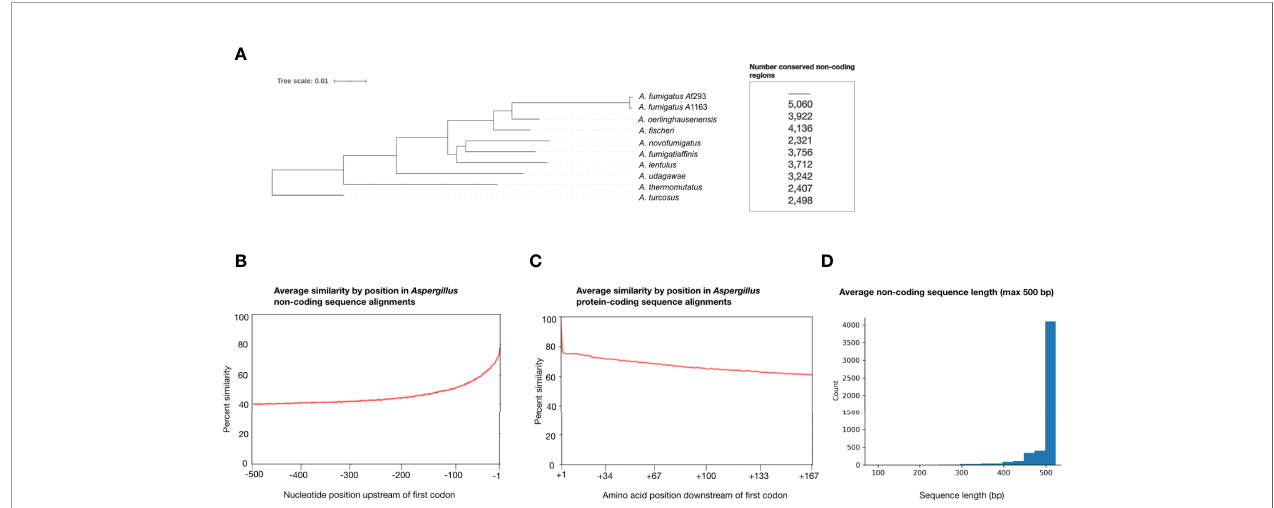
concatenation analysis of a 5,215-gene data matrix. Branch lengths correspond to nucleotide substitutions/site. Note the long branch leading to A fumigatus , indicative of a greater number of nucleotide substitutions per site in this species. The number of genes whose non-coding regions were conserved ( ≥ 75% sequence similarity between each species and ≥ 500 bp in length) between A. fumigatus Af293 and each species are shown next to the corresponding taxa. (B) Average percent sequence similarity of non-coding regions of 5,215 genes byposition,relativeto the gene ’ s fi rst codon. Sequence alignments ofnon-coding regions were comparedby position and the average percentsimilarities for each site are reported with -1 indicating the site directly upstream ofthe fi rst codon and -500 indicating the site 500 bpupstream of the fi rst codon. (C) Average percent sequence similarity byposition of the fi rst 167 aminoacid sites in the alignments of 5,215 genes, relative to the gene ’ s fi rst codon.The average percent similarity for each site isreported, with +1 indicating the fi rst aminoacid. (D) Average sequence alignment lengthsof the 5,215 non-coding regionsexamined inthis study.4,079 of the 5,215 non-codingregionshave ≥ 500 bpin all10 strains/species used inthis